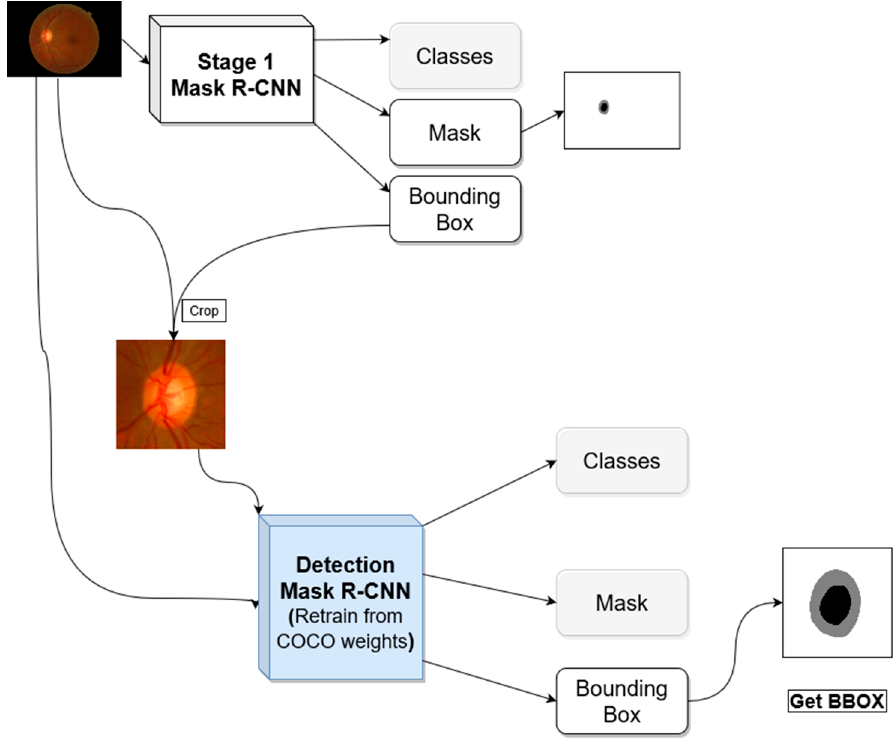
Figure 6. Proposed detection network training .